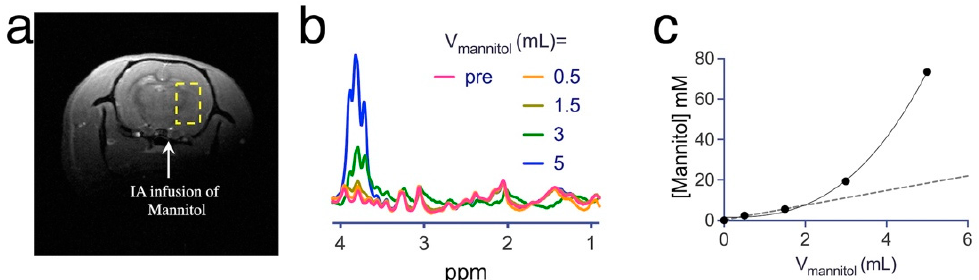
Figure 3. MRS assessment of the brain accumulation of administered mannitol (25% w / w ). ( a ) Representative T 2w anatomical image showing the location of intra-arterial (IA) infusion (white arrow) of mannitol and the voxel (yellow dashed line) for 1 H-MRS measurement. ( b ) 1 H-MRS spectra as a function of the injection volume of mannitol. ( c ) Calculated mannitol concentration (mM) in the brain as a function of injection volume, where dash line is the linear regression of the first three data points of low doses.